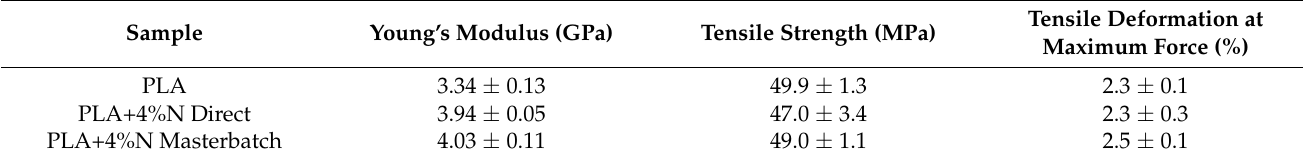
Table 1. Tensile and Flexural Properties of PLA and PLA+4%Nanoclays using the different compounding methods.